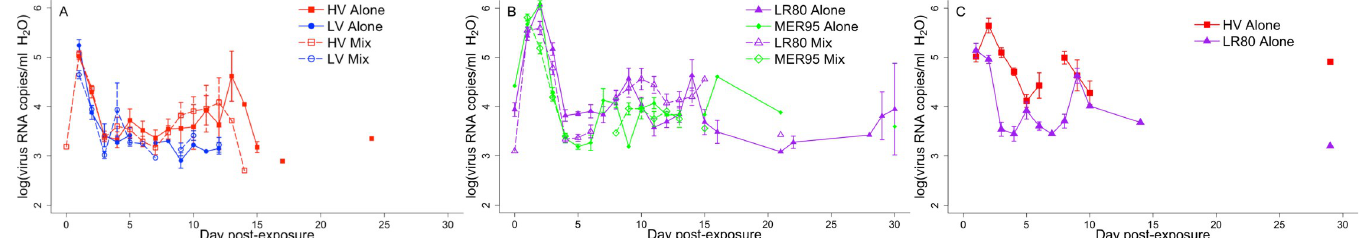
Fig 3. Virus shedding intensity. Panels show the mean amount of IHNV [log10(virus RNA copies/ml H 2 O)] shed per day for genotypes HV (red squares), LV (blue circles), LR80 (purple triangles), and MER95 (green diamonds), in experiments 1 (A), 2 (B), and 3 (C). Points represent days samples were taken to quantify viral shedding in single (closed symbols and solid lines) and mixed infections (open symbols and dotted lines). Error bars show +/- 1 standard error of the mean. Only live fish shedding detectable virus into the water were included in the figure. A missing point indicates no virus shedding was detected by qPCR for all fish in a given treatment. Points not connected by a line indicate virus dropped below detection at sampling time points in-between. Points without standard error bars indicated fewer than 2 fish were positive for virus. Number of fish included in the mean values for each data point are the number of live fish shedding at the same time point in Fig 2.